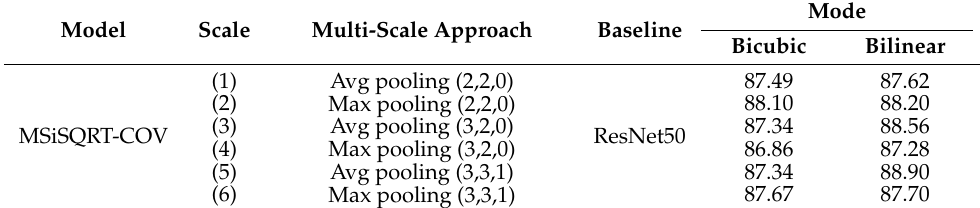
Table 4. Classification accuracy under different upsampling